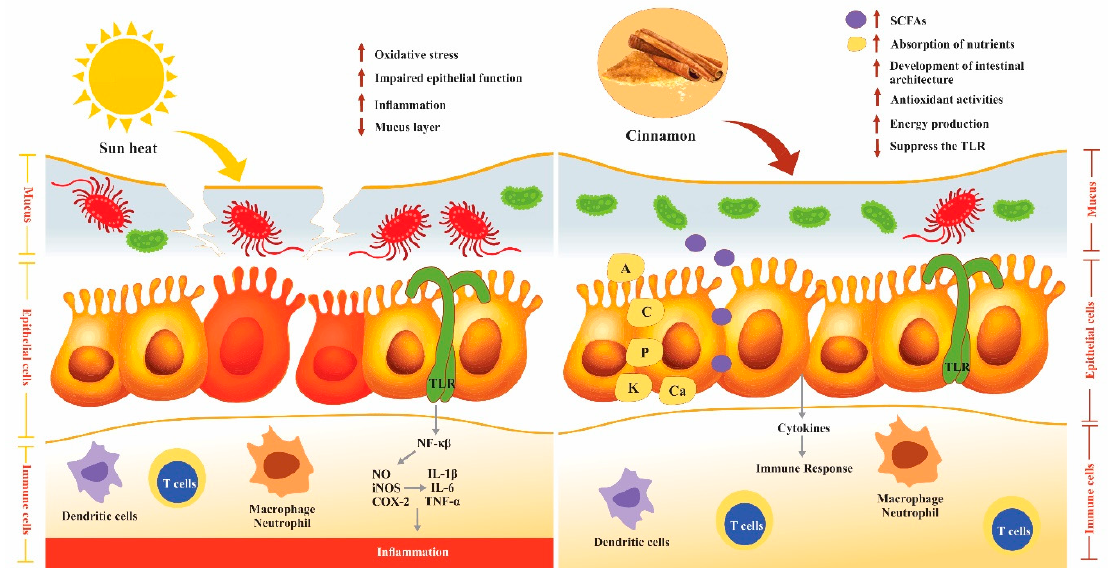
Figure 2. Effect of heat stress on immune response and cinnamon contribution to modulate oxidative stress due to pathogenic bacteria impaired the epithelial cells and mucus and cause inflammation by triggering the toll-like receptors (TLR) ( Left side ). Cinnamon improved the intestinal lumen by improving the growth of commensal bacteria and suppressing the TLRs. Good bacteria produce SCFAs, develop the intestinal architecture and produce energy ( Right Side ).